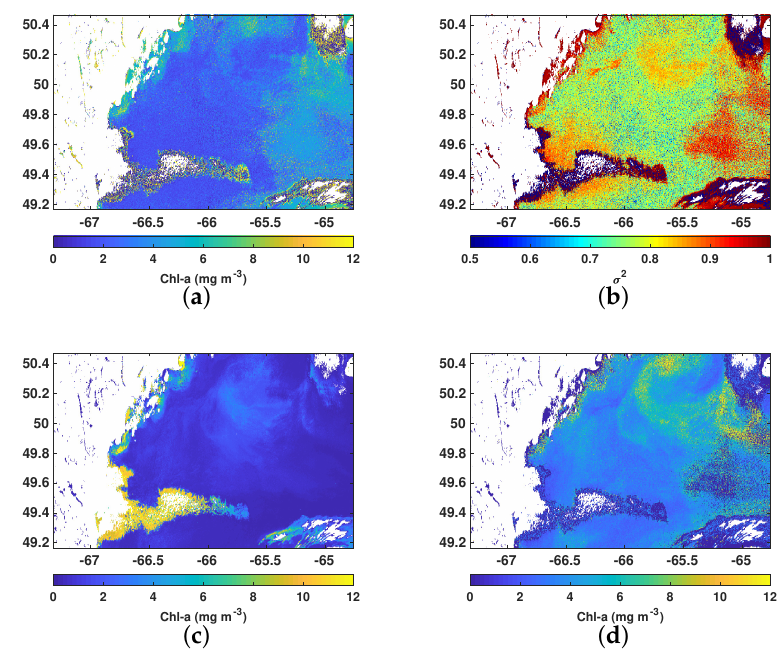
Figure 11. Region 2: Estimated Chl-a concentration ( a ) and the corresponding certainty map ( b ). Chl-a concentration map by the NNs ( c ) and OC4 ( d ). The unit of Chl-a is mg m − 3 , and the certainty (variance) is